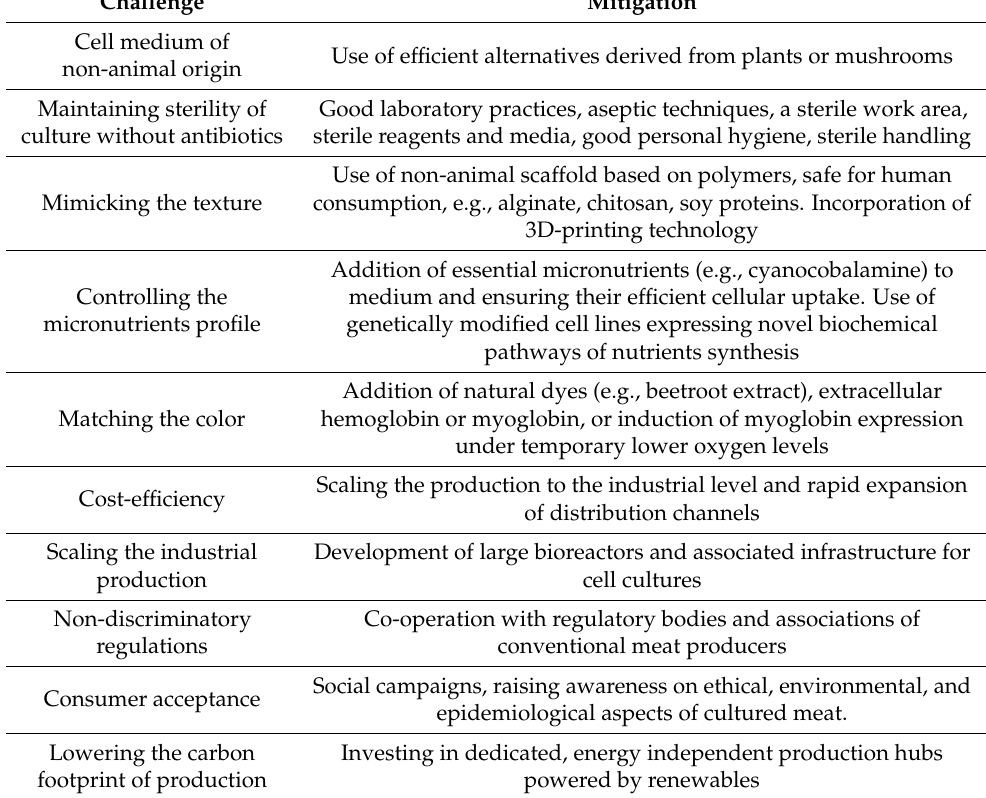
Table 2. The main challenges for the development and commercialization of cultured meat products and potential mitigation